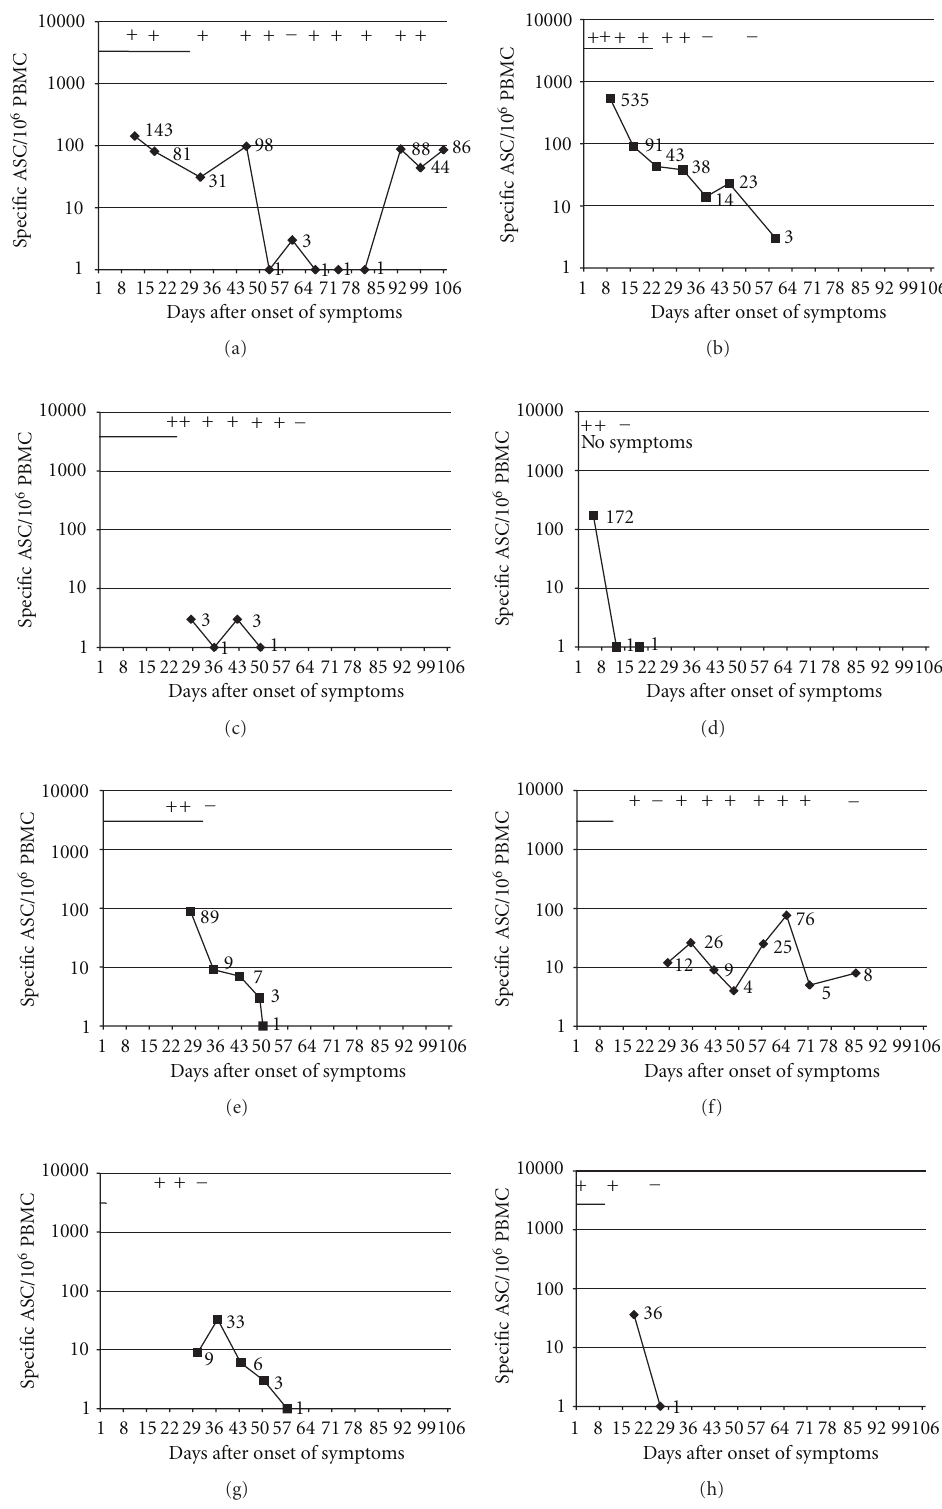
Figure 2: Relation of pathogen-specific circulating plasmablasts (black curve) with symptoms (black horizontal line) and findings in stool samples (+ or − ) in eight patients with gastroenteritis caused by Salmonella enteritidis . To determine the kinetics of the response, the numbers of plasmablasts were assessed on several occasions as long as they were found in the samples or the pathogen could be isolated from the stool samples, and the patient was available. The plots represent each data from one individual. The day of the onset of the symptoms was marked as day